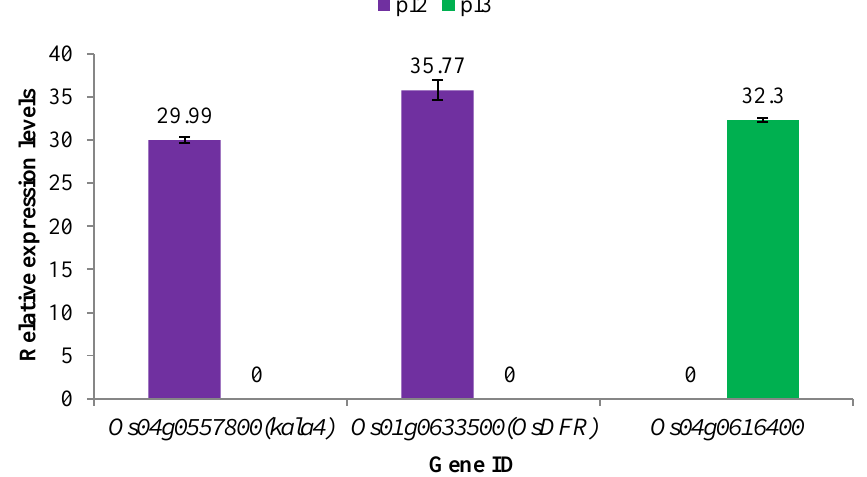
Figure 5. qRT-PCR to verify the DEGs via RNA-Seq. The abscissa is the gene accession, and the ordinate is the relative expression level of the gene.